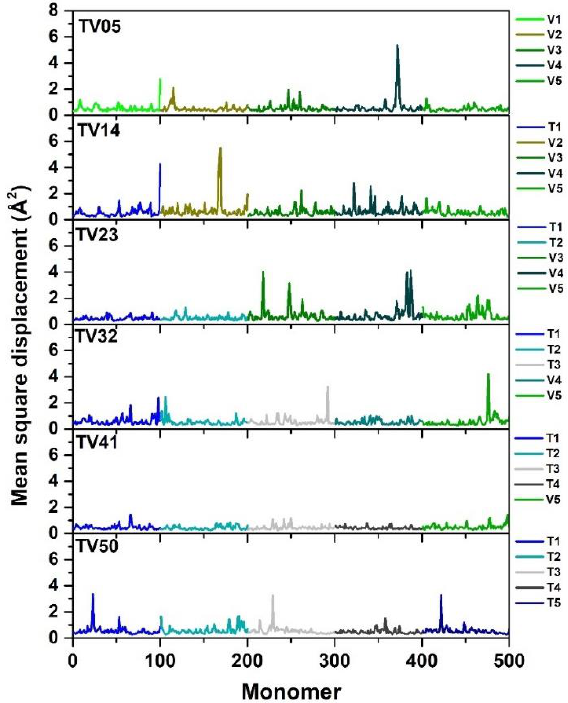
Figure 5. The mean square displacement of the PET/PEV blend system for the 5 ns. Each system consisted of 5 single chains of PET and/or PEV represented by T and V, respectively.